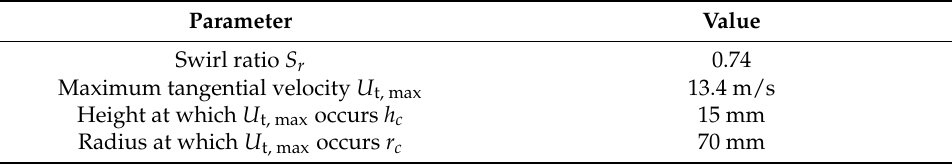
Figure 6. Characteristics of the tornado-like vortex. ( a ) Mean tangential velocity; ( b ) pressure drop; ( c ) mean radial velocity, the direction pointing to the vortex center is positive; and ( d ) mean axial velocity, the direction of vertical upward is positive. Table 4. Parameters of the tornado-like vortex.